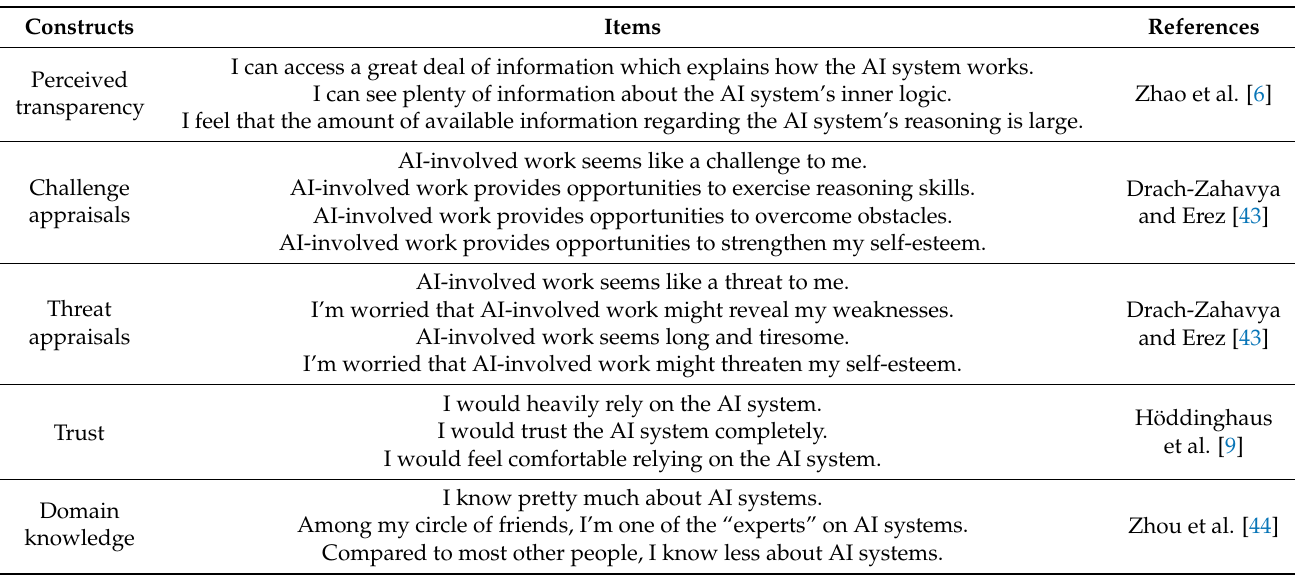
Table 1. Measurement items of each